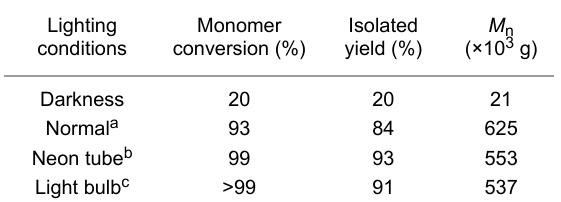
Table 2: Effect of light on the ROMP of cyclooctene using 16g as cata- lyst.